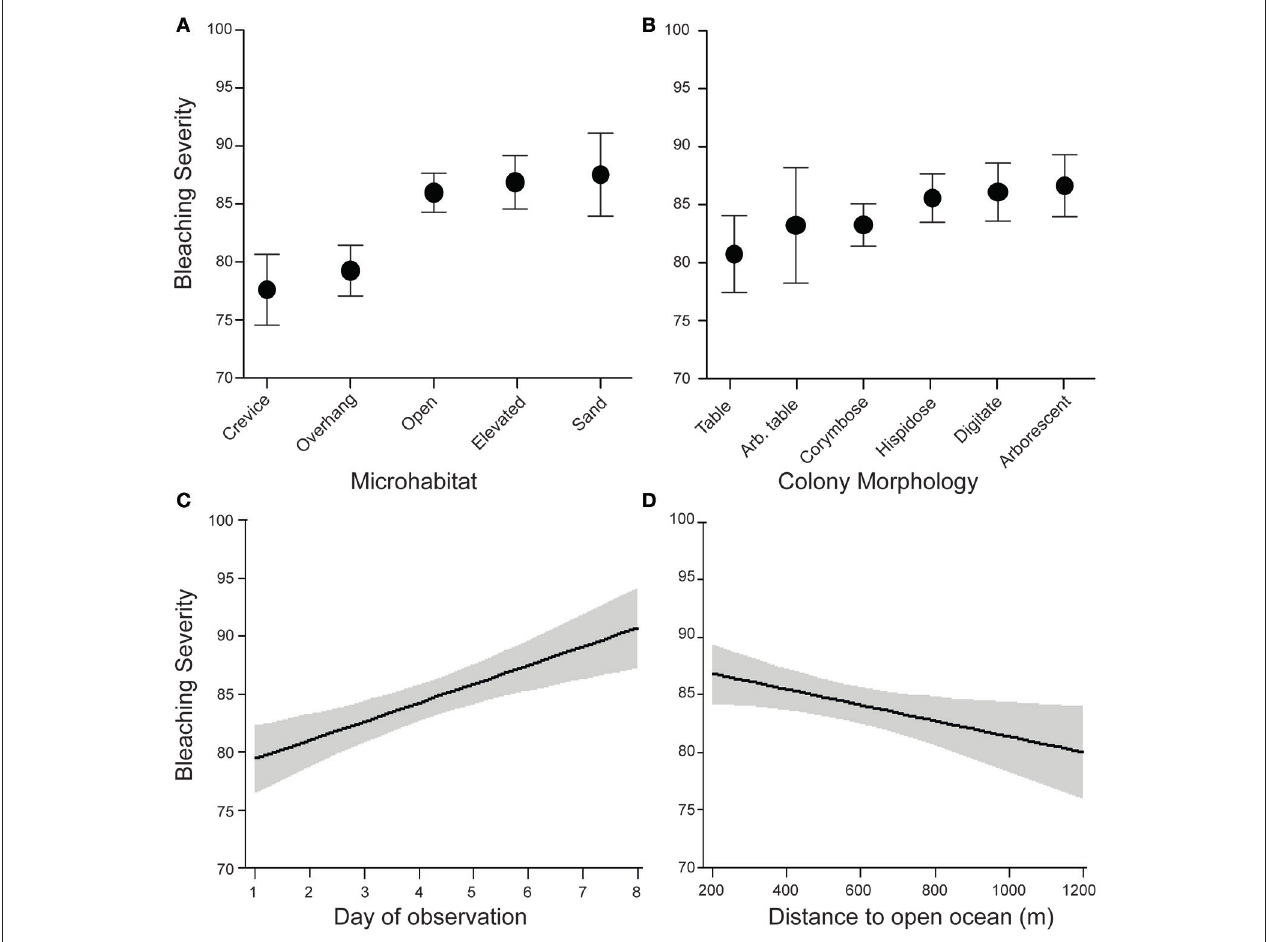
FIGURE 2 | Environmental and morphological correlates of bleaching severity for corals at sites around Lizard Island in March 2016. Data show effects of (A) microhabitat, (B) colony morphology, (C) day of observation and (D) distance to open ocean from linear mixed effects model with N = 596 coral colonies, site included as a random effect, and main effects of the minimal model obtained from backwards deletion of non-significant